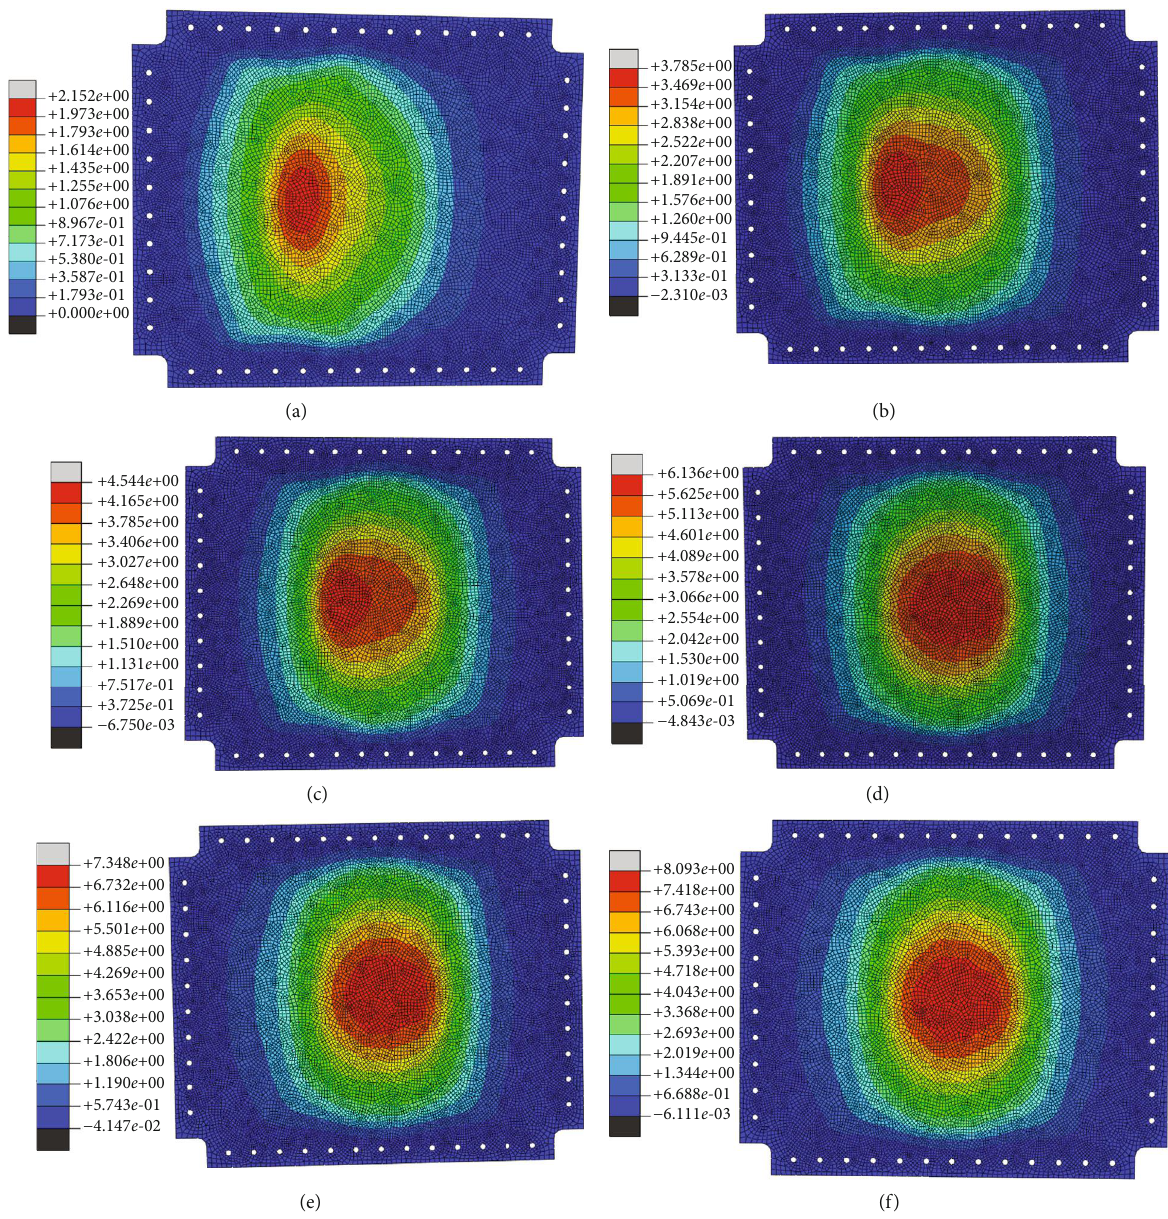
Figure 22: Di ff erent angles of skin displacement clouds. (a) 15 ° , (b) 20 ° , (c) 25 ° , (d) 45 ° , (e) 60 ° , and (f) 75 ° . Table 11: Response of battery box under di ff erent bird impact